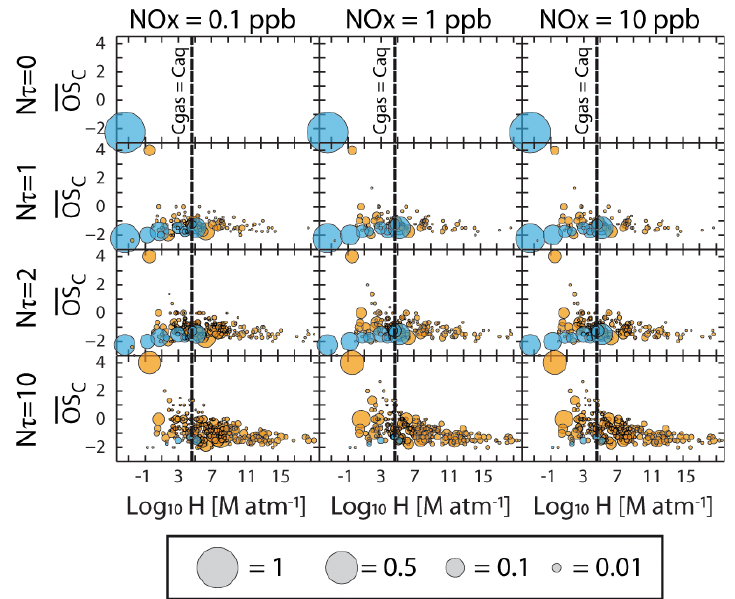
Fig. 7. Solubility and mean oxidation state of the species produced during the oxidation of octane under low NO x (1st column), intermediate NO x (2nd column) and high NO x (3rd column) conditions as a function of the number of precursor lifetime. See Fig. 6 caption for the color code of the bubbles.